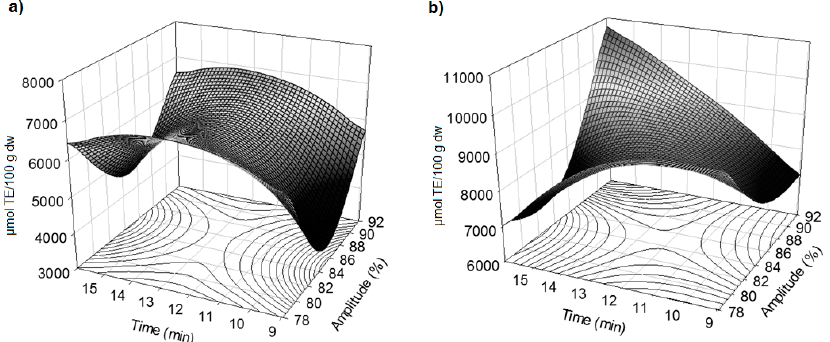
Figure 2. Response surface plots showing the effect of amplitude and time on ( a ) antioxidant activity by the ABTS method (µmol of Trolox equivalent/100 g dry weight basis) and ( b ) DPPH method (µmol of Trolox equivalent/100 g dry weight basis) obtained by ultrasound from blackberry residues. The quadratic terms of amplitude ( β 11 ) and time ( β 22 ) significantly influenced ( p < 0.01 and